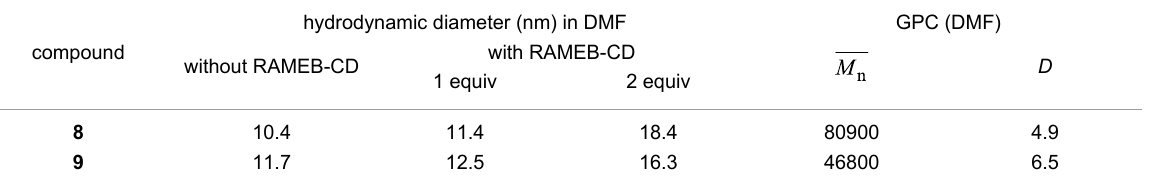
Table 2: The hydrodynamic diameters and molecular weights of the polymers 8 and 9 and their complexes with RAMEB-CD in DMF.